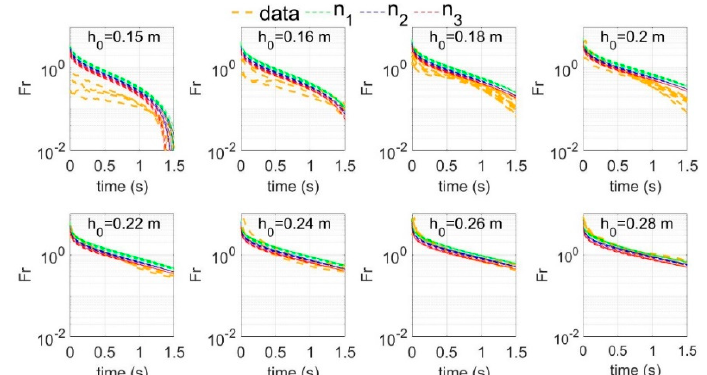
Figure 7. Froude number evolution at P2. Yellow dash lines are experimental data. The green, blue, and red lines refer to Manning’s coefficients n 1 = 0.0125 m − 1/3 s, n 2 = 0.0175 m − 1/3 s, and n 3 = 0.0225 m − 1/3 s, respectively. Curves are displayed in the first 1.5 s because in all the cases in which the block was unstable (see Table. 1) mobilization occurred within this time interval.